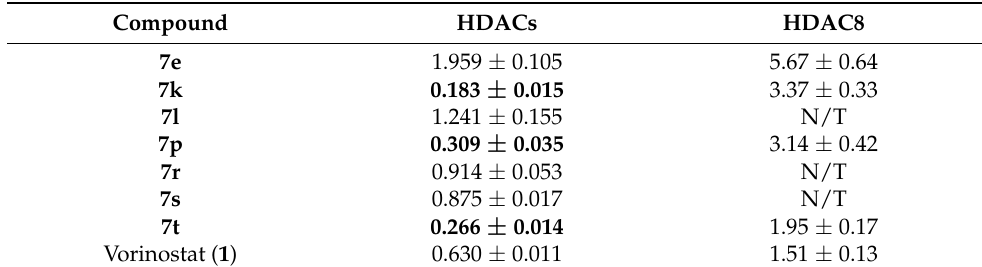
Figure 4. HDACs activity inhibition for the most active compounds. Table 2. Inhibition of HDAC homologues (HDACs) and HDAC8 activity (IC 50 [ µ M]) for selected compounds. N/T—not tested.